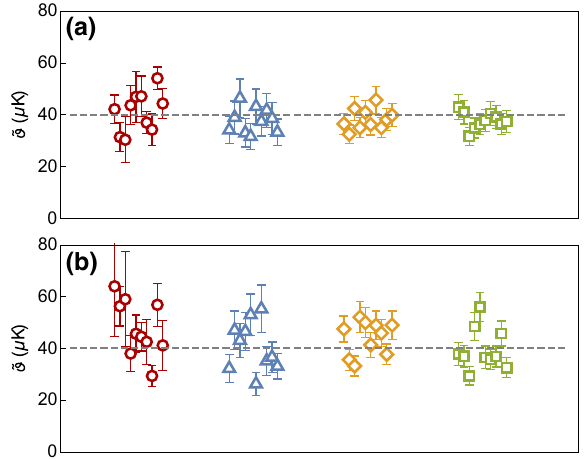
FIG. 3. Estimate variability of different strategies. Tempera- ture estimates drawn from simulated release-recapture measure- ments on 41 K. The parameters for the simulations are those of the deep-trap experiment from Sec. IV A and Fig. 2(b), and the true temperature is set to 40 μ K (dashed gray). In (a), the mean number of atoms loaded into the trap is assumed to be known, FIG. 2. Temperature estimation from measurements at unop- and equal to λ = 1.65. In each case, ten independent runs of timized recapture times. Empirical mean and standard error of the experiment are simulated, consisting of 30 measurements the number of recaptured 41 K atoms (black dots) at each free- generated at each of the seven unoptimized recapture times t b . expansion time in the two experiments described in Sec. IV A The estimates are calculated via the conventional least-squares for a (a) shallow and (b) deep trapping potential. The solid method (red circles) and the Bayesian approach (blue triangles). red curves are two-parameter nonlinear fits to λ f ( T , t ) in λ Since λ is known, the least-squares method becomes a one- and T , where f ( T , t ) is the survival probability from Eq. (9). parameter fit. Orange rhombs and green squares correspond to These yield (a) T a = 15.8 ± 32 μ K and λ a = 1.84 ± 11 and estimates drawn from the a priori optimized and fully adaptive (b) T b = 57 ± 11 μ K and λ b = 1.66 ± 9. In turn, the Bayesian protocols, respectively. These also run on datasets of 210 mea- strategy (cf. Sec. II C 1) applied to the full measurement record surements. The a priori optimal recapture time here is t s = 22 μ = 15.0 ± 17 μ K and (b) T (cid:9) = 45 ± 7 μ K. The gives (a) T (cid:9) a b insets show the estimates. The dashed blue curves correspond to λ f ( t , T ) evaluated at temperatures T (cid:9) and T (cid:9) , with initial average a b = 1.88 and λ (cid:9) = 1.65, as calculated from the atom numbers λ (cid:9) a b calibration measurements.